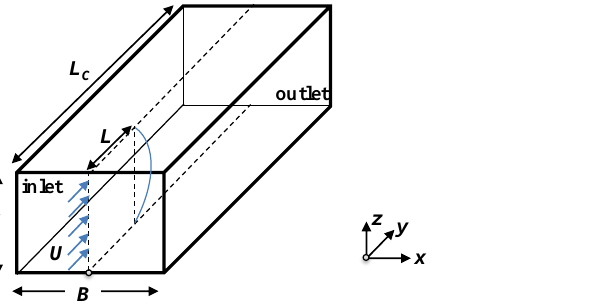
Figure 1. Schematic representation of the channel geometry. L is the dimensional development length.